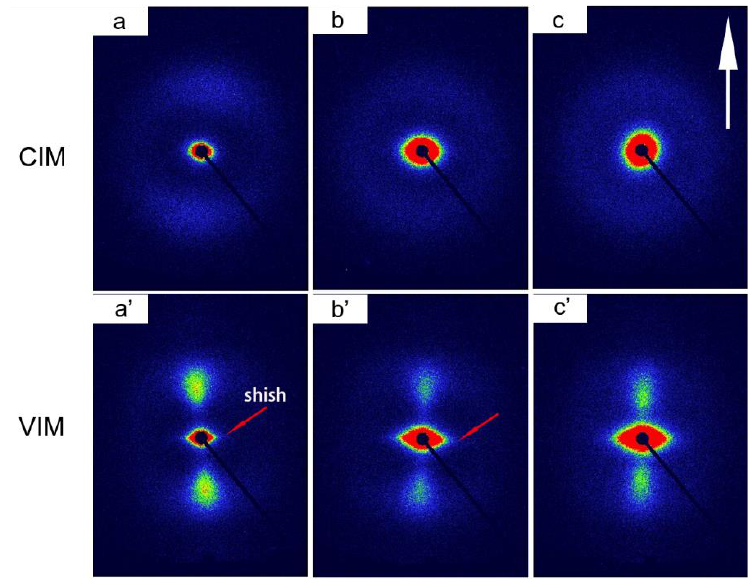
Figure 3. Typical 2D-SAXS patterns: ( a , a’ ) is pure PP; ( b , b’ ) is CIM/VIM-10; and ( c , c’ ) is CIM/VIM-10-C. The white arrow depicts the flow direction.